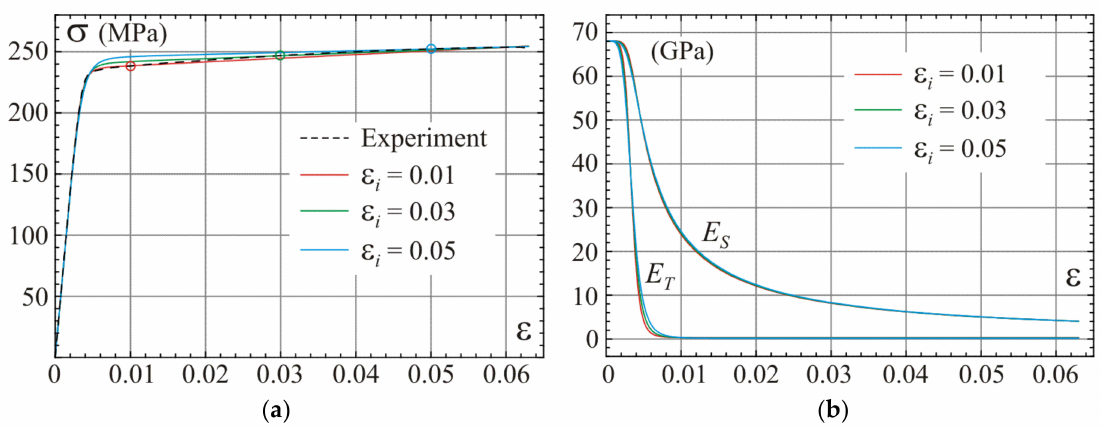
Figure 4. Influence of selecting the calibration point on the hardening stage for the one-dimensional model. ( a ) Calibrated constitutive relations, ( b ) secant and tangent